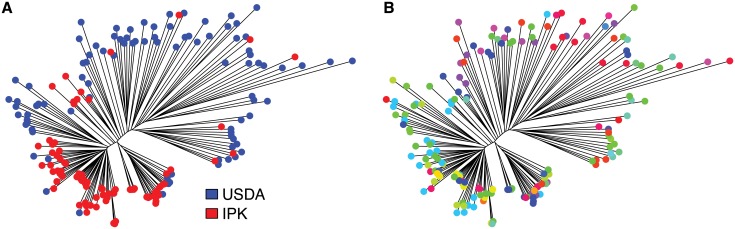
Neighbor joining tree of 174 cauliflower accessions.The NJ tree is based on the pairwise distance matrix using data without missing values (1,444 SNPs). (A) The two genebanks are represented as different colors. (B) Each country of origin of the original seeds as stated in the passport information is represented with a different color.